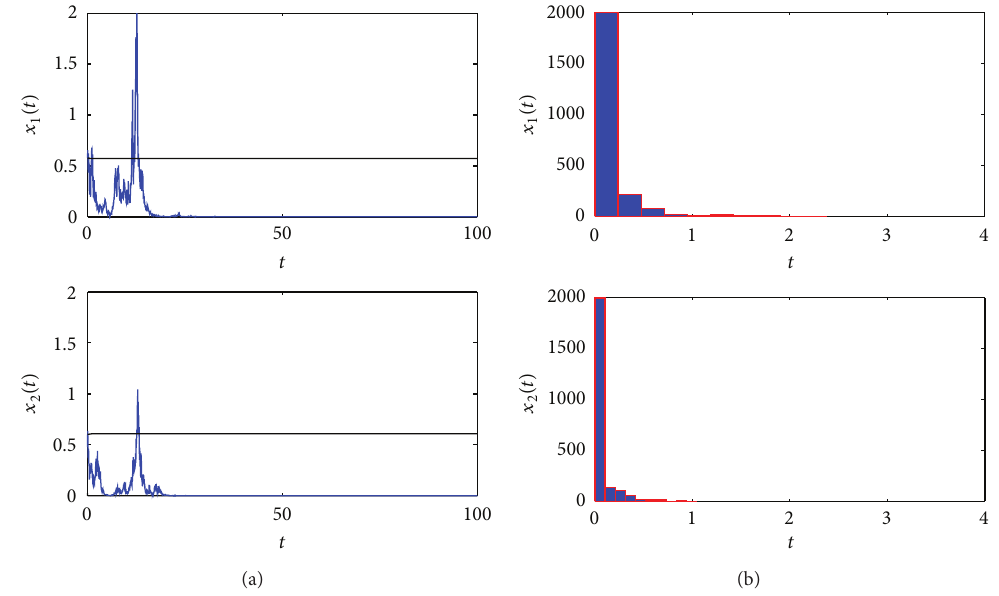
Figure 7: The subgraphs are defined as in Figure 4; 𝜎 1 = 0.9 , 𝜎 2 = 1 . The populations of 𝑥 1 and 𝑥 2 will become extinct.